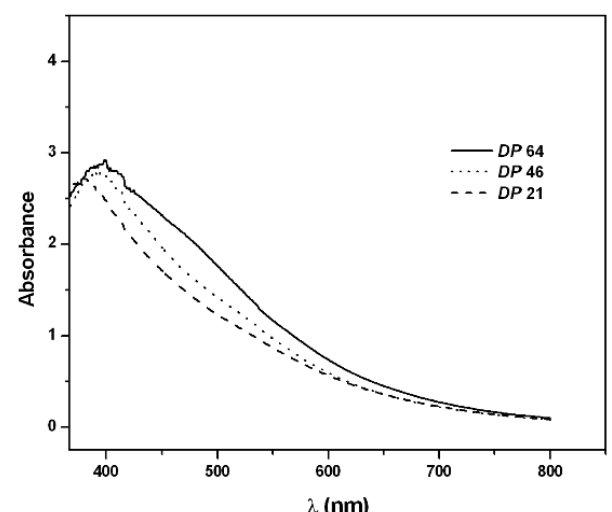
Figure 6. UV-vis spectra of PAPy in trifluoroacetic